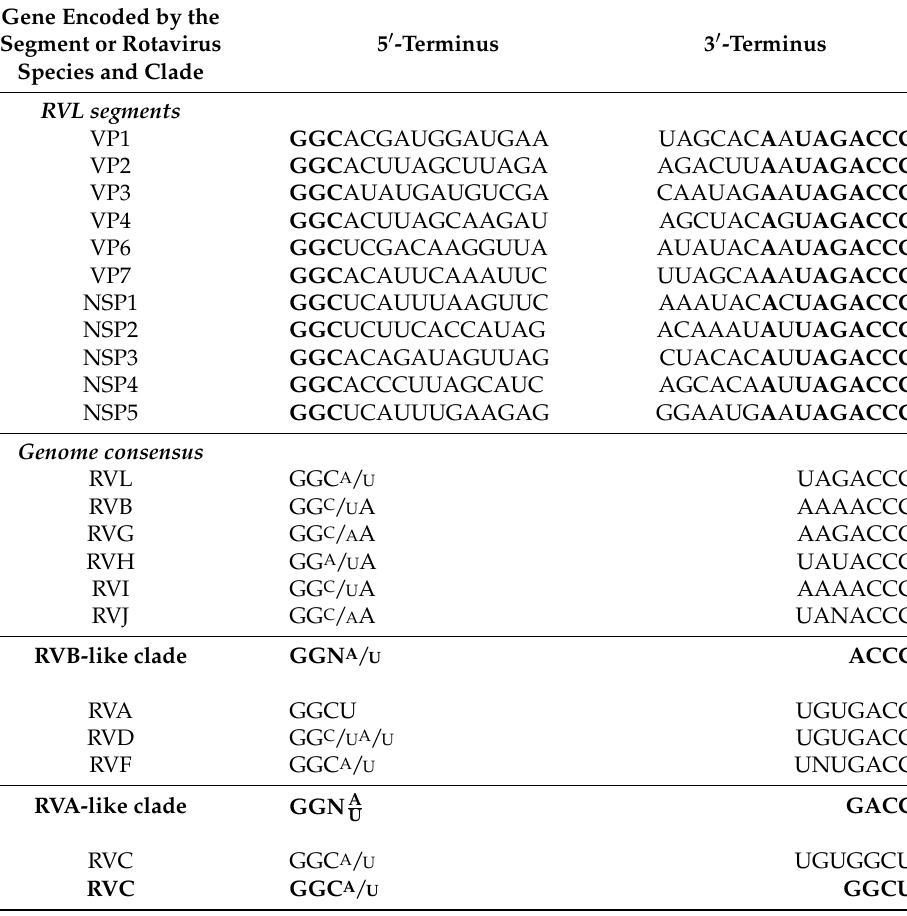
Table 2. Comparison of the 5 (cid:48) - and 3 (cid:48) -terminal (positive-sense RNA strand) genome segment se- quences of RVL strain KS14/0241 with the reference strain sequences of the other rotavirus species (as specified in Supplementary Data S1). Nucleotides present at the same position of the NCRs in all segments of RVL and consensus sequences of all rotaviruses belonging to a clade (RVA-, RVB-like) or RVC are shown in